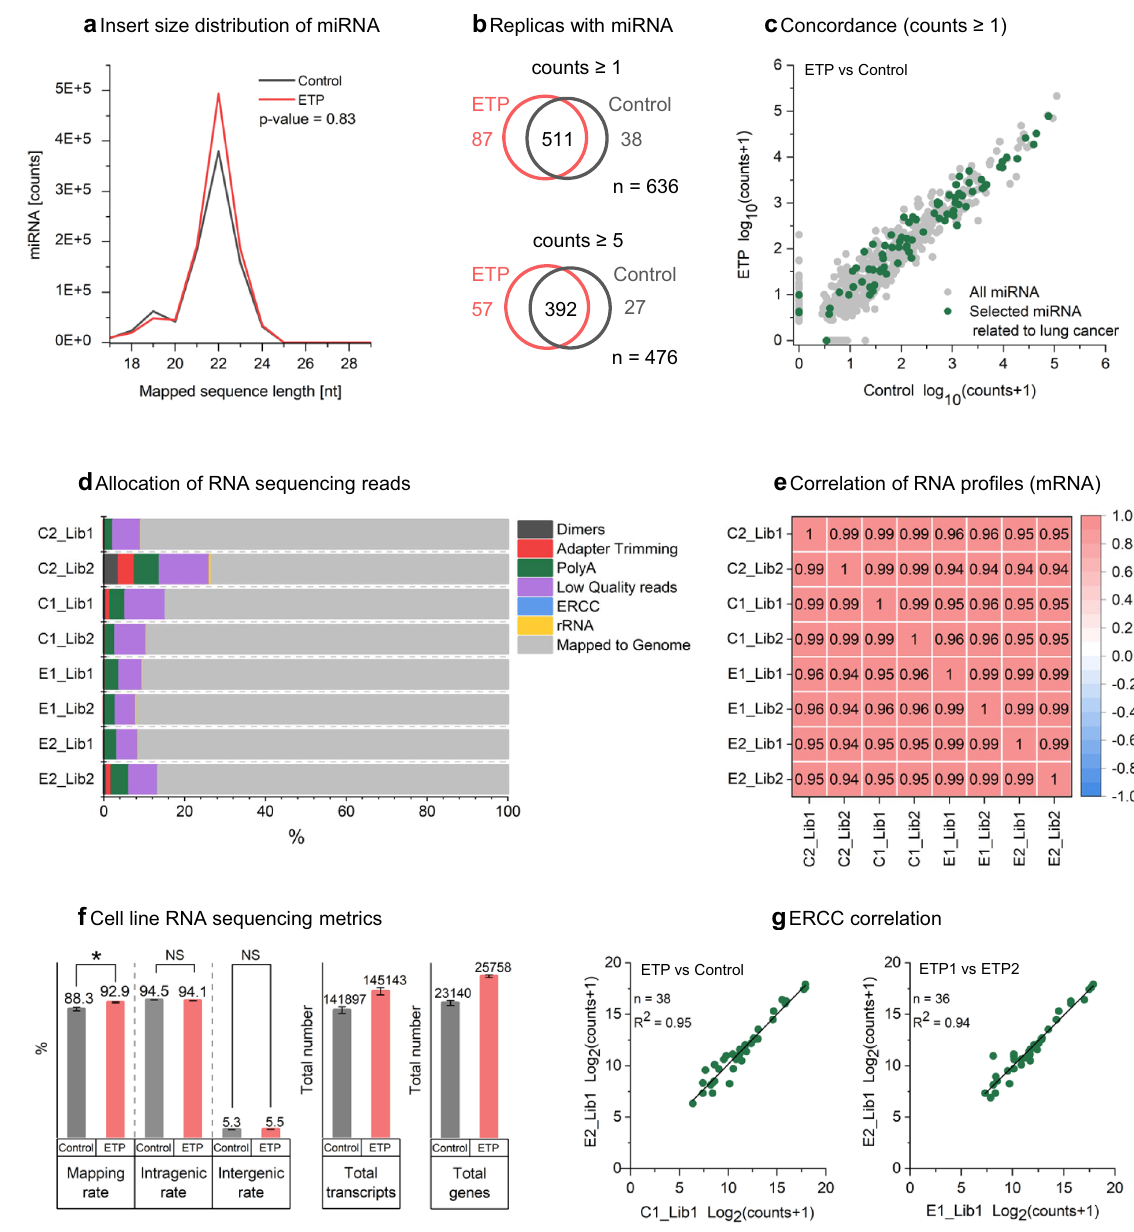
Figure 2. Lung Adenocarcinoma cell line ETP miRNA and RNA sequencing results from total nucleic acid extraction. ( a – c ) miRNA extraction and sequencing. Control—ReliaPrep™ miRNA Cell and Tissue Miniprep System kit. Sequencing libraries were subsampled to 20 million read pairs. ( a ) Fragment length distribution of mapped miRNA reads. ETP—plotted in red, Control—plotted in grey. ( b ) Venn diagram of miRNA detected from ETP and Control. Transcripts that are present in all samples ETP and column with normalized counts for each known miRNA ≥ 1, and ≥ 5. ( c ) Detection of miRNA implicated in lung cancer 15 . ( d – g ) RNA sequencing using random priming RNA sequencing library prep (Kapa RiboErase kit). Reads were subsampled to 20 million read pairs. Sample labeling as follows: ETP (E), Control (C) technical replicates (C1, C2, E1, E2) and Library replicates (Lib1, Lib2). ( d ) Allocation of reads. From left to right—filtered reads (primer-dimers, adapter dimers, PolyA trimming (< 30 nt), low quality reads (< 30 nt, Cut adapt quality = 28), reads aligned to ERCC, rRNA and mapped to the human genome. ( e ) Spearman correlation matrix for cell line RNA sequencing. Pairwise correlation score across ETP and column samples. Correlation scores range from − 1 (anti-correlation, blue) to 1 (strong correlation, red). ( f ) RNA Sequencing Metrics: Mapping rate, Intragenic (exons) and Intergenic (introns) rates, total detected transcript isoforms and genes. ( g ) ERCC Correlation between ETP and